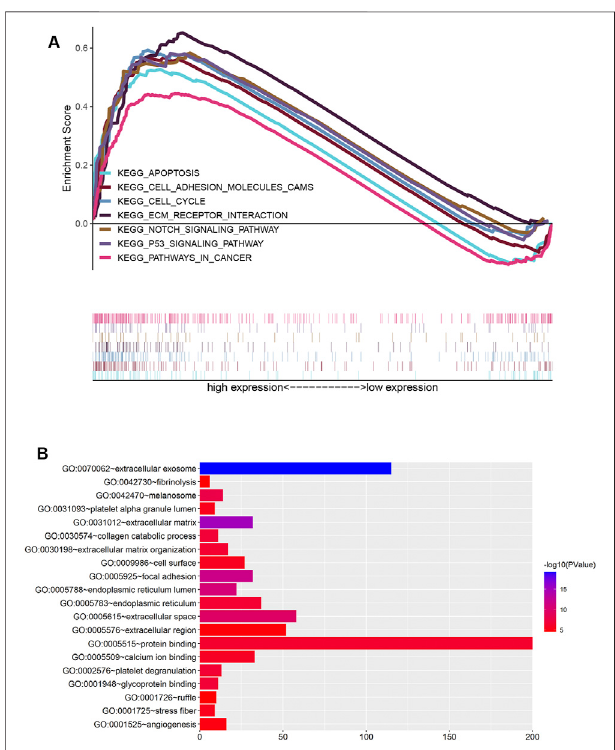
FIGURE5| Functional enrichment analysisofFam20c inLGG. (A) Gene Ontologyenrichmentanalysis; (B) enrichmentplotsfromGSEA.KEGG,Kyoto Encyclopedia of Genes and